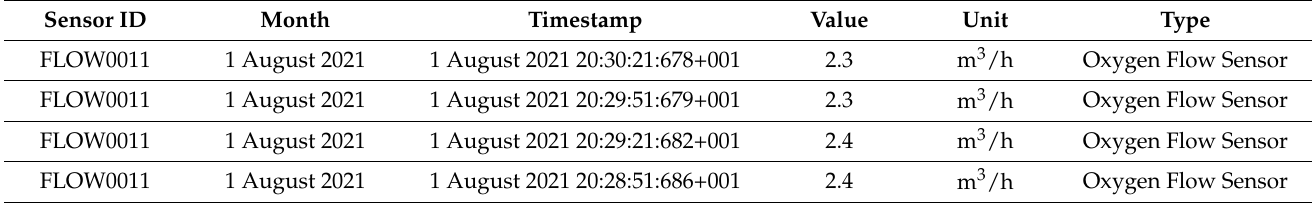
Table 1. Excerpt from data_by_poll_sensor table in Cassandra.